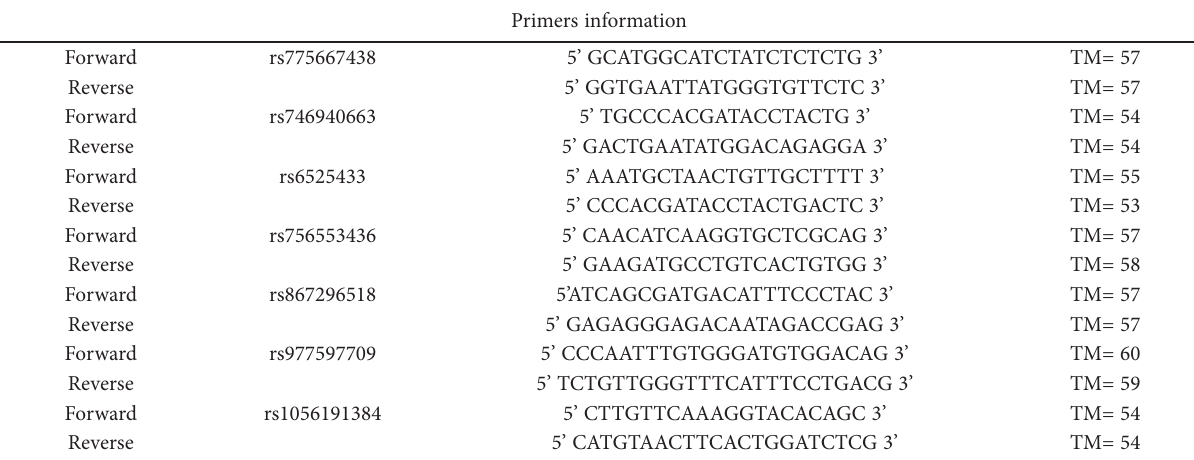
Table 1. Seven different TEX-11 gene regions for